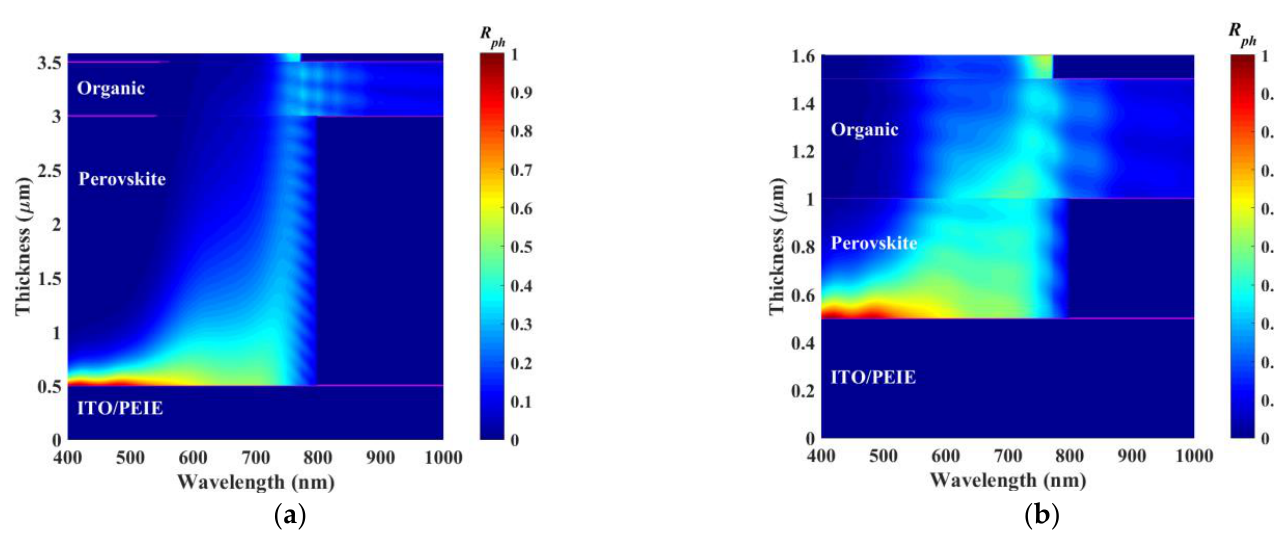
Figure 4. Simulated normalized nonlinear contours of photon absorption rate with a perovskite thickness of ( a ) 2.5 μm and ( b ) 0.5 μm.